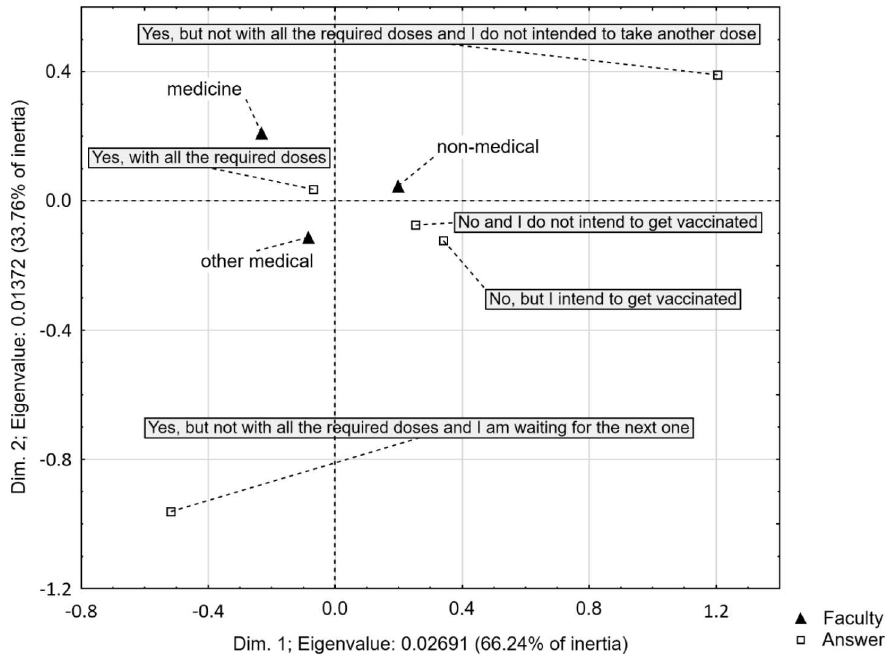
Figure 1. Correspondence map: faculty vs. answer to the question: Have you been vaccinated against COVID-19?